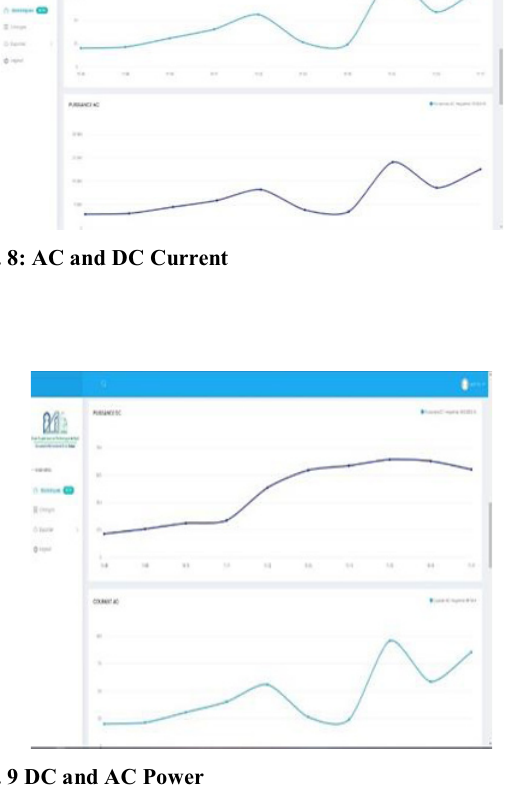
Fig. 9 DC and AC